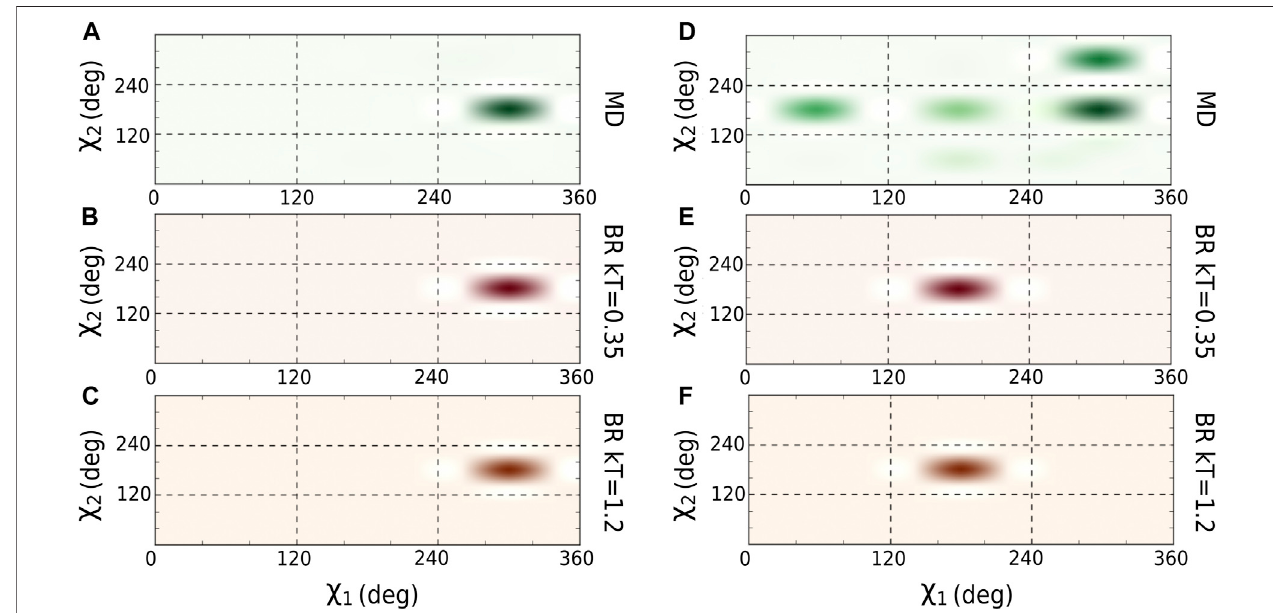
FIGURE 2 | Comparison of χ 1 and χ 2 distributions for amino acid Leu9 from the peptide bound to MHC class II (PKYVKQNTLKLAT PDB id: 1fyt). (A) Last 10 ns of MD, (B) Backrub using kT (cid:1) 0.35, and (C) Backrub using kT (cid:1) 1.2. The same analysis was done for amino acid Arg15 of another peptide (AAYSDQATPLLLSPR PDB id